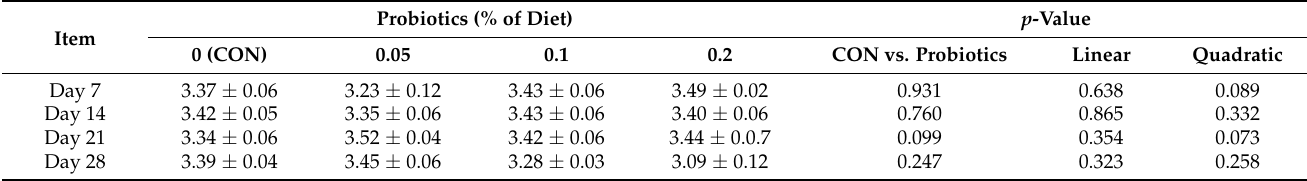
Table 6. Effects of dietary complex probiotic supplementation on fecal score in growing pigs.